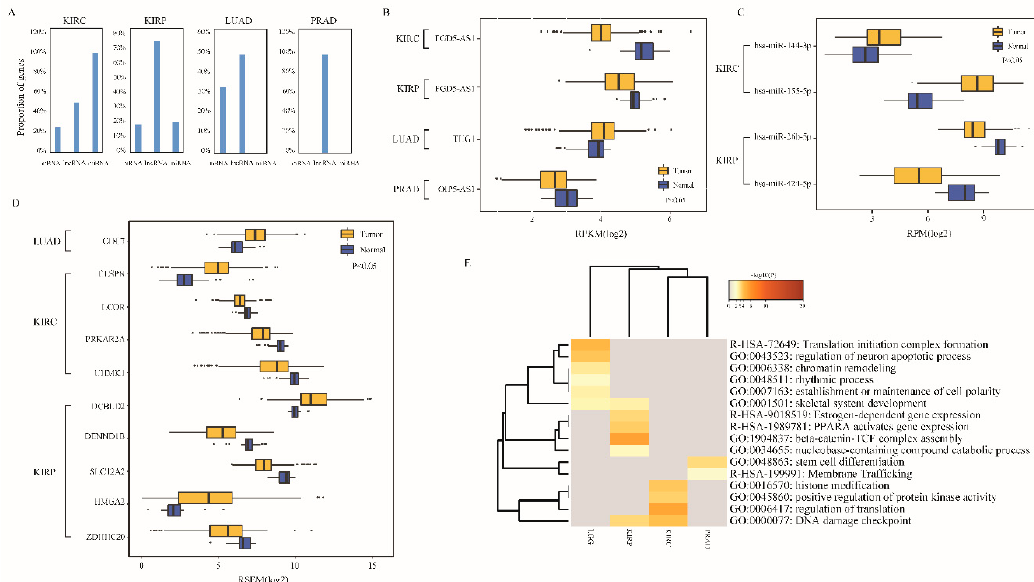
Figure 4. Enrichment analysis elucidates the critical functions of the lncRNA perturbators in cancer. ( A ) Proportion of di ff erentially expressed mRNAs, lncRNAs and miRNAs in 4 cancer types. ( B – D ) The di ff erentially expressed lncRNAs, miRNAs and mRNAs in cancer. ( E ) Enrichment result of lncRNA perturbators in 5 cancer types. Each column represents a cancer type and each row represents a Gene Ontology term or a pathway. The color of each table cell corresponds to a di ff erent p -value (scale bar, − log10( p ) value). Lower grade glioma, LGG; kidney clear cell carcinoma, KIRC; kidney papillary cell carcinoma, KIRP; lung adenocarcinoma, LUAD; prostate cancer, PRAD.